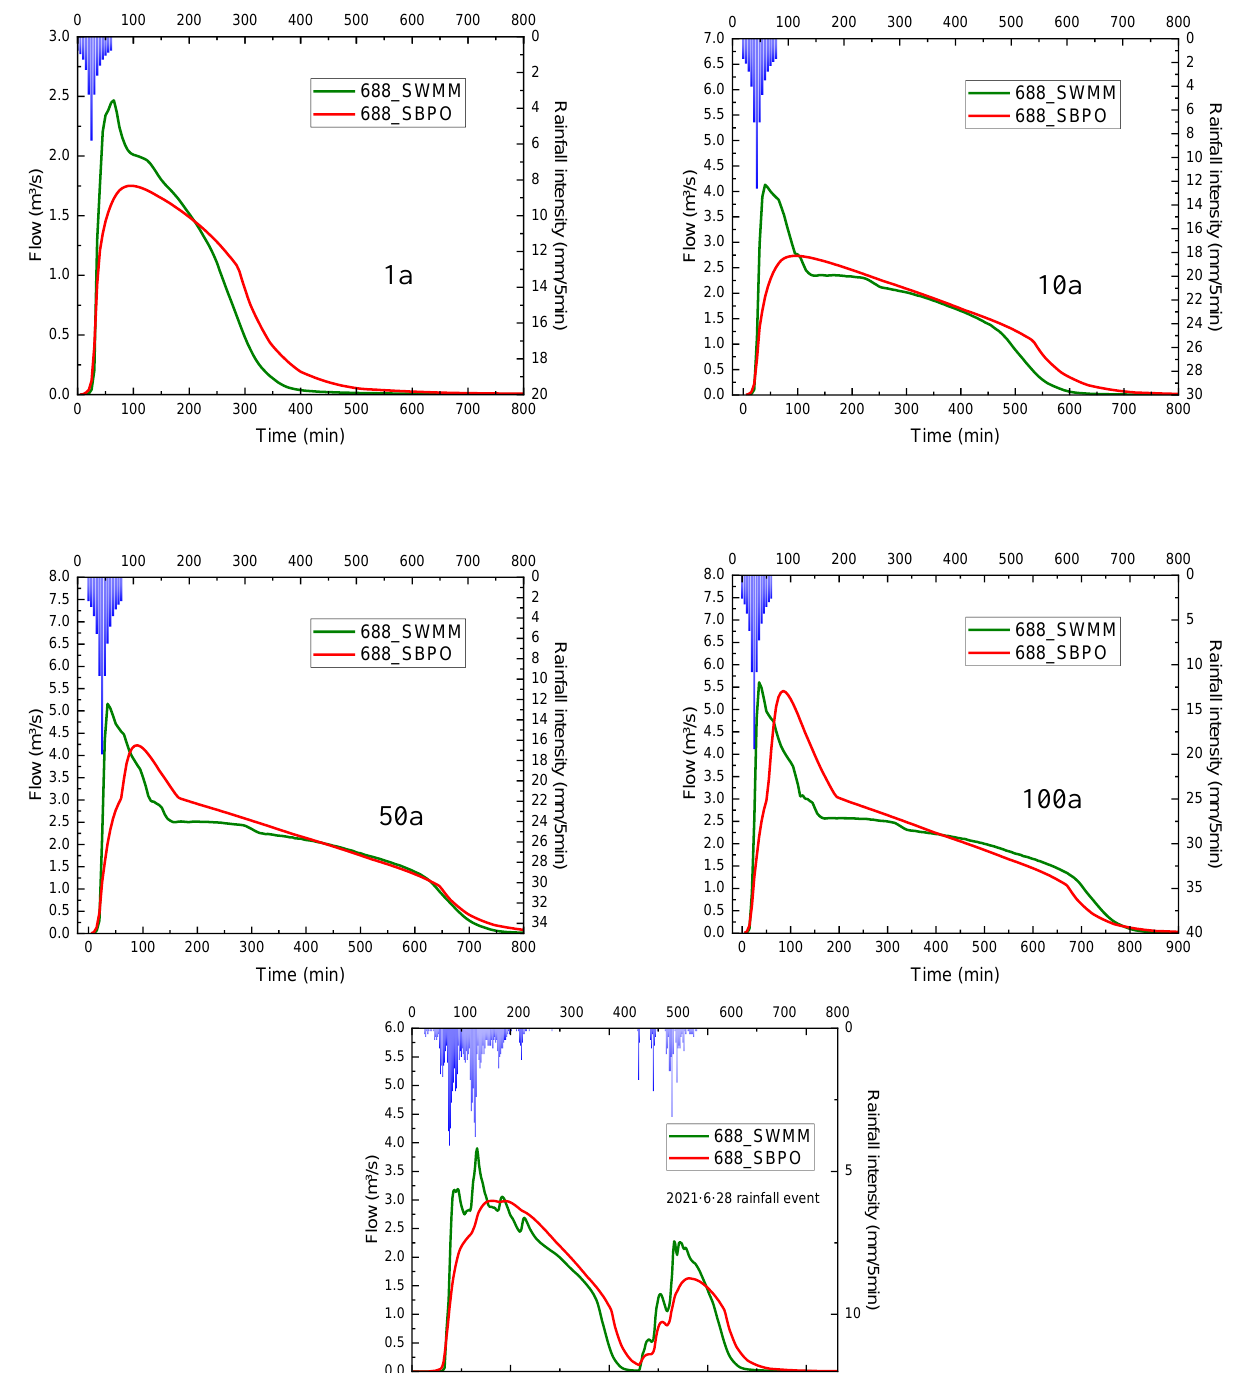
Figure 12. “688” outfall flow rate comparison.